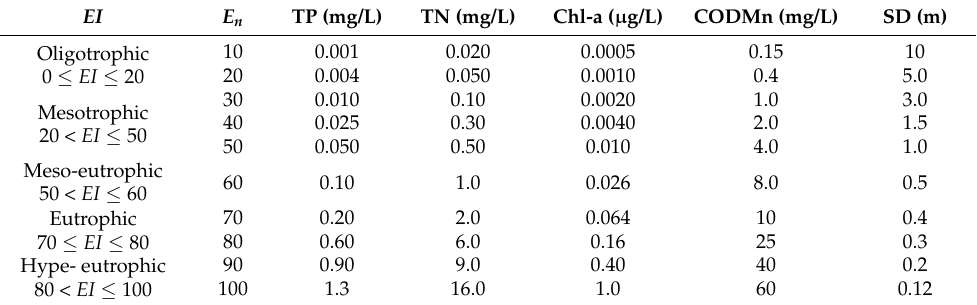
Table 2. Lakes (reservoirs) eutrophication assessment methods and classification technology requirements.